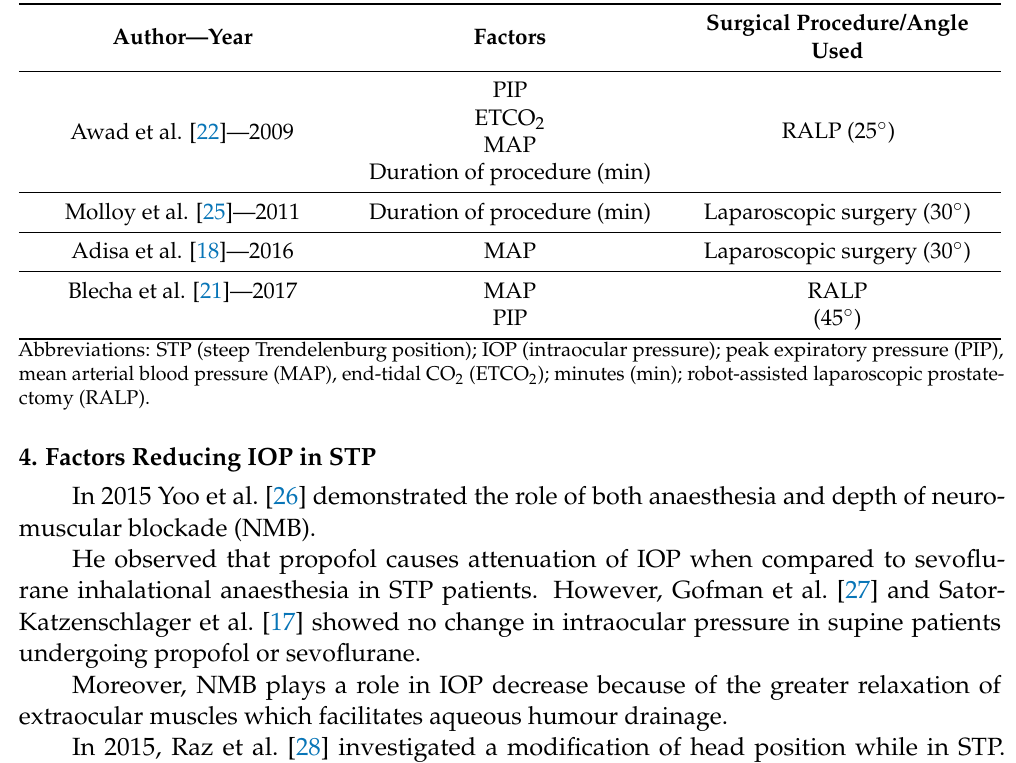
Table 1. Factors determining increased IOP in